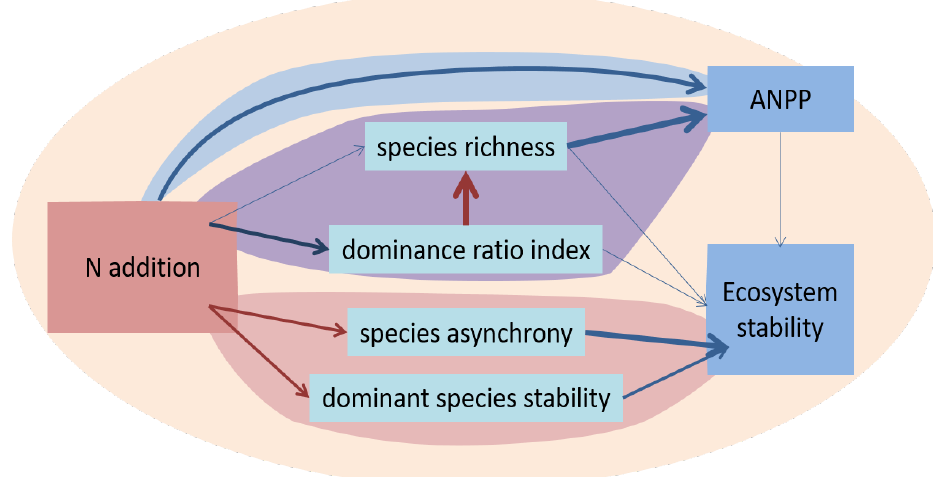
Figure 3. Modified after Liu et al. [74]: An example of causal relationships in fertilized grassland. Blue arrows: positive effects; red arrows: negative effects. Arrow width indicates strength of effect. An odd number of red arrows in a pathway implies a negative effect. For example, high asynchrony between species stabilizes the system, but N-addition reduces asynchrony, so that particular pathway reduces stability.